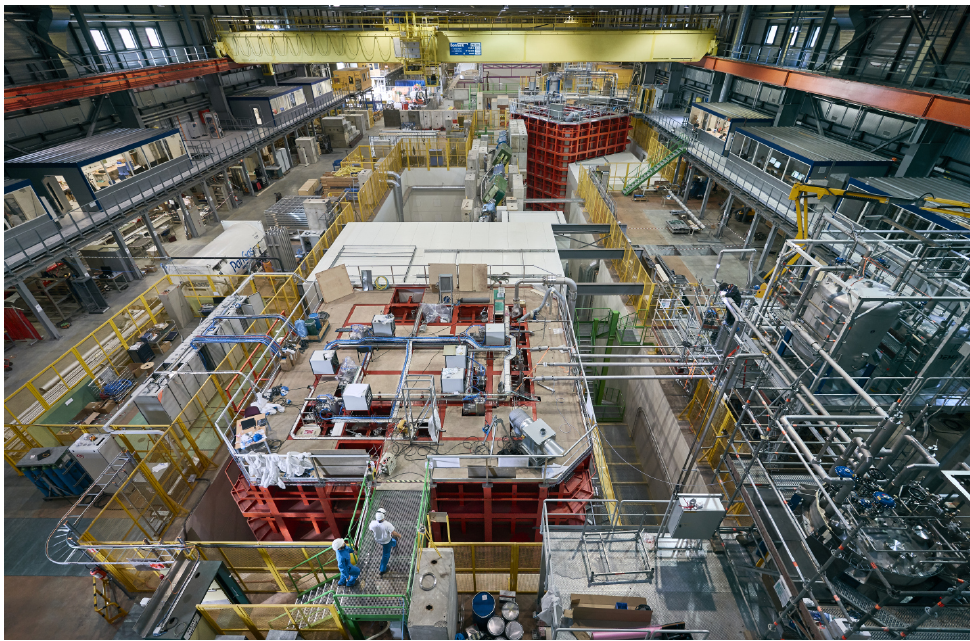
Figure 12. ProtoDUNE-SP (in the foreground) and ProtoDUNE-DP (in the background) installed at the CERN Neutrino Platform. Image: